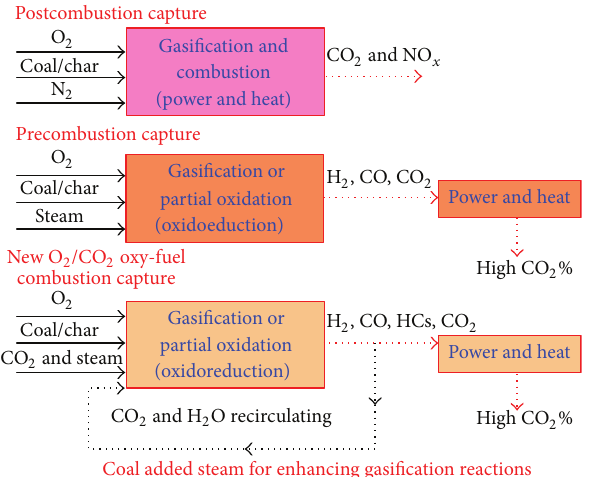
Figure 1: Schematic diagram of three kinds of power generation with CO 2